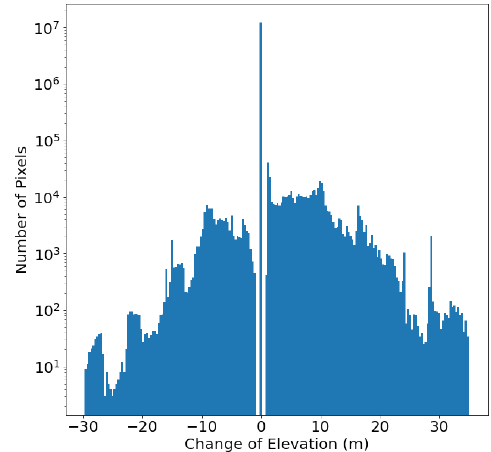
Figure 6. Pixel distribution in train